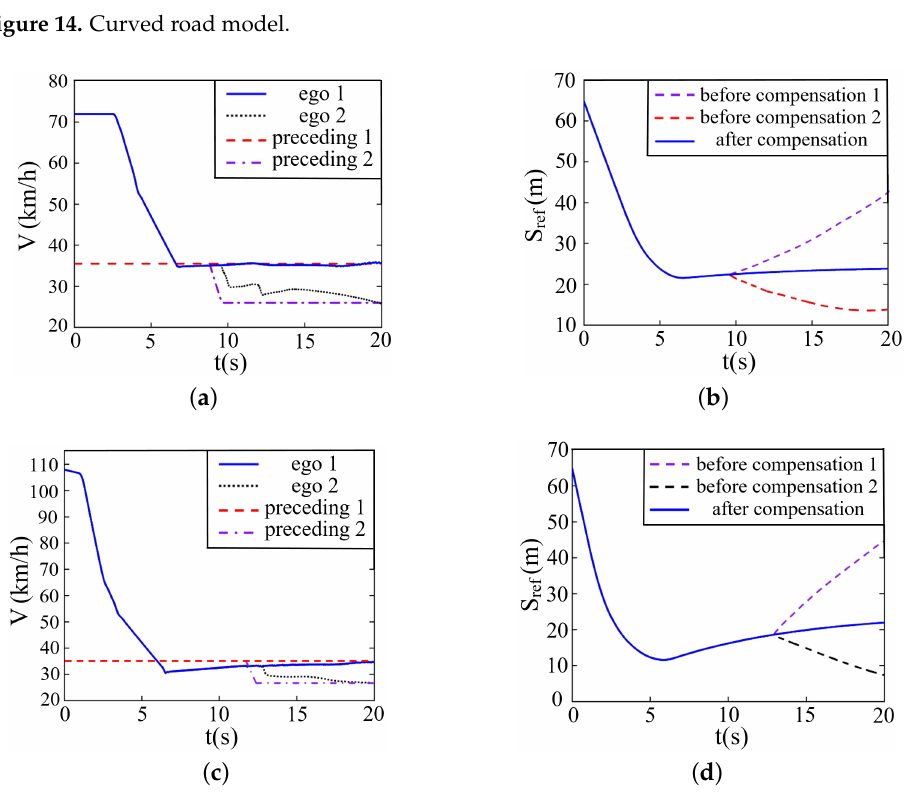
Figure 15. Simulation on curved roads when preceding vehicle drives at a constant speed. ( a ) Velocity (72 km/h). ( b ) Relative distance (72 km/h). ( c ) Velocity (108 km/h). ( d ) Relative distance (108